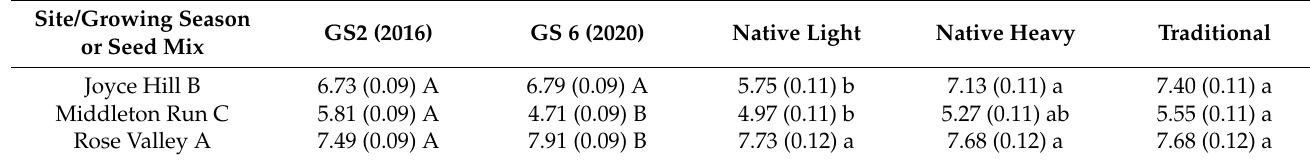
Table 3. Soil pH values by site and growing season (GS) interaction and by site and seed mix treatment interaction. Values are estimated marginal means with one standard error in parentheses. Šid á k-adjusted comparisons were made among estimated marginal means. Growing seasons followed by the same upper-case letter are not significantly different at p < 0.05. Pairs of values of the seed mix treatment within a site followed by the same lower-case letter are not significantly different at p <